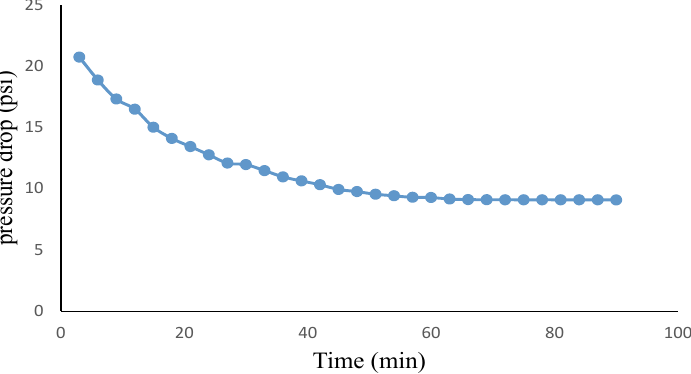
Fig. 8: Pressure drop between the inlet and outlet of the sand pack during oil injection.